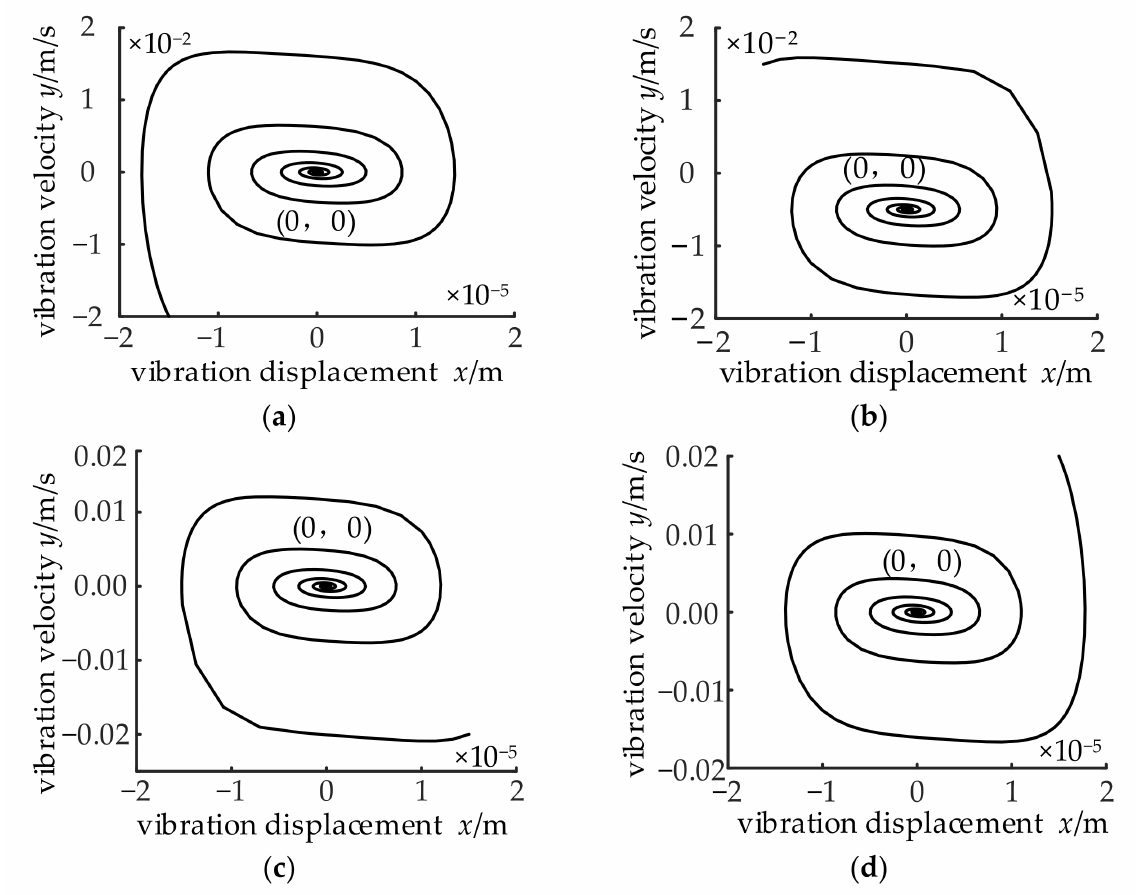
Figure 7. Phase trajectories when K p = − 70. ( a ) ( − 1.5 × 10 − 5 , − 0.02). ( b ) ( − 1.5 × 10 − 5 , 0.02). ( c ) (1.5 × 10 − 5 , − 0.02). ( d ) (1.5 × 10 − 5 ,